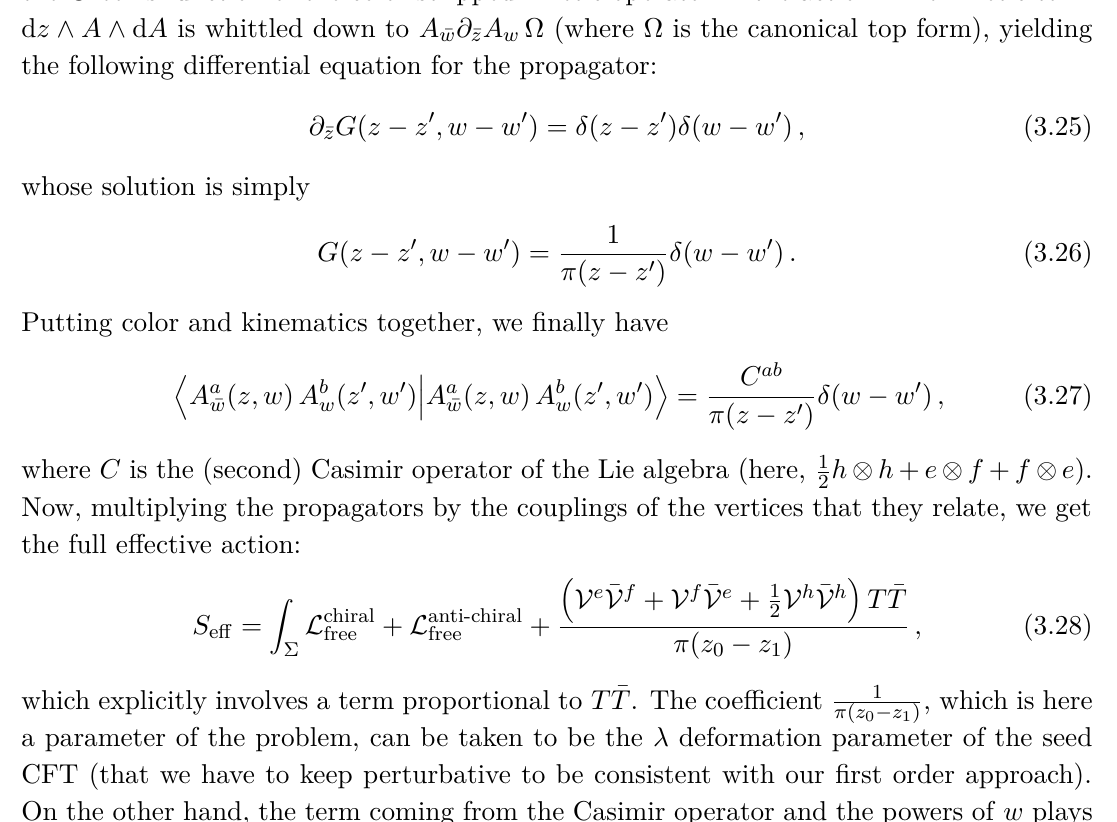
Figure 1 . Only two types of vertices participating in the effective action. a and b are such that (cid:0) (cid:1) Tr t a t b 6 = 0 with Tr the non-degenerate invariant bilinear form of sl 2 and t a the generators of sl 2